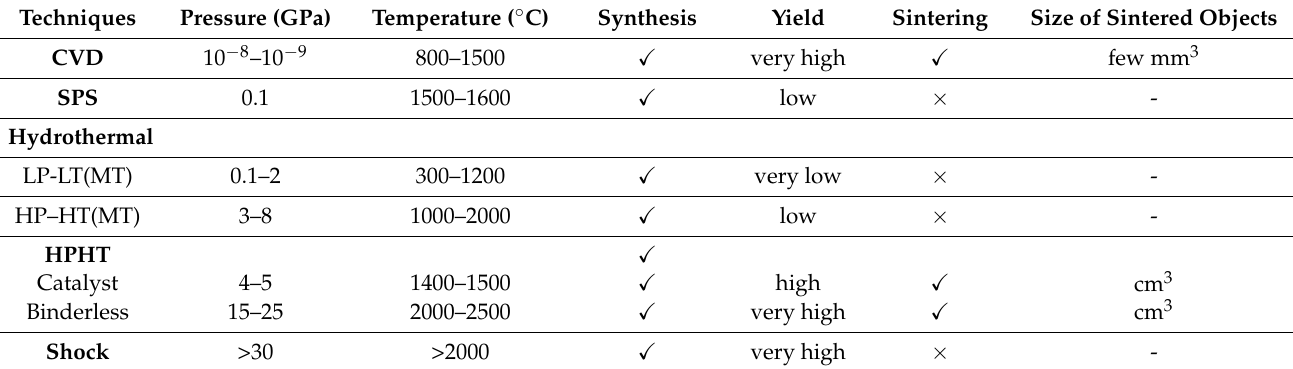
Table 4. Summary of P–T conditions of the different techniques to synthesize and/or sinter